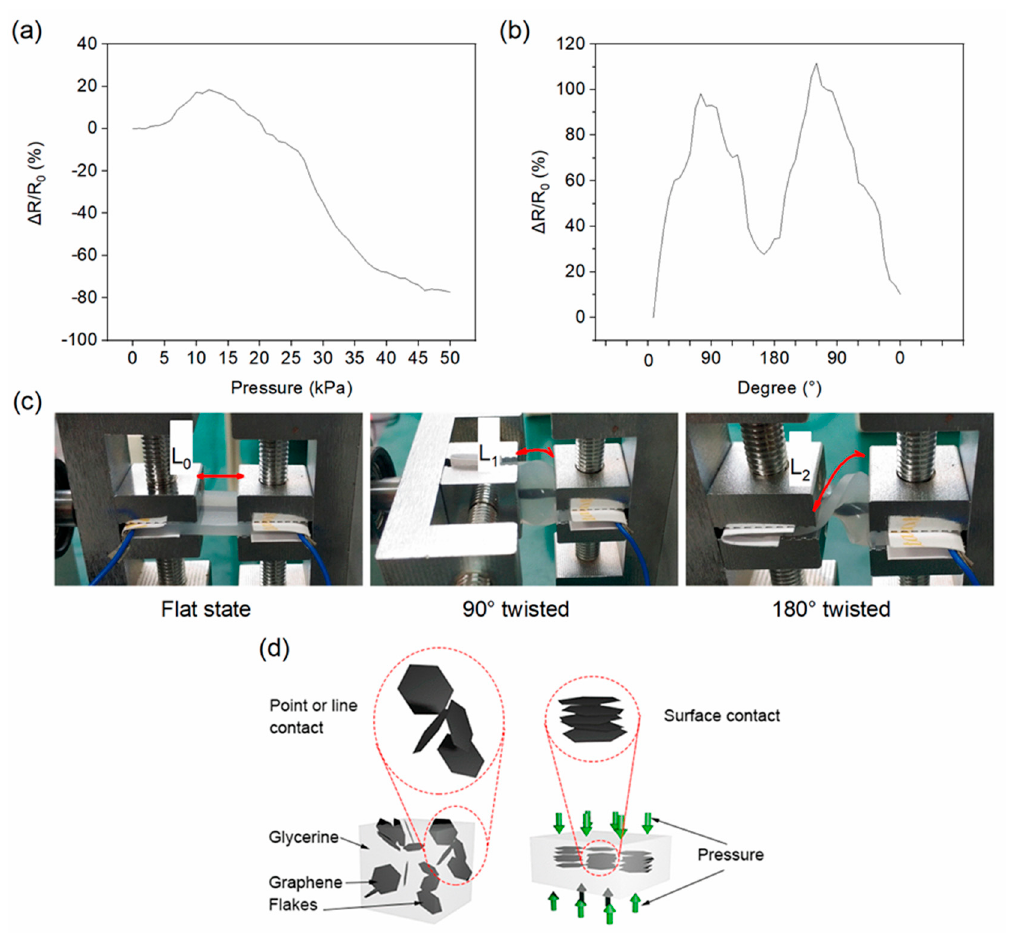
Figure 5. The G / GL based sensor used for pressure and twisting measurements, ( a ) relative resistance variation responses for increasing pressure, ( b ) relative change of resistance versus twisting, ( c ) different states of the sensor during twisting process, ( d ) schematic illustration of the mechanism of the electromechanical responses of the strain sensor under compression.